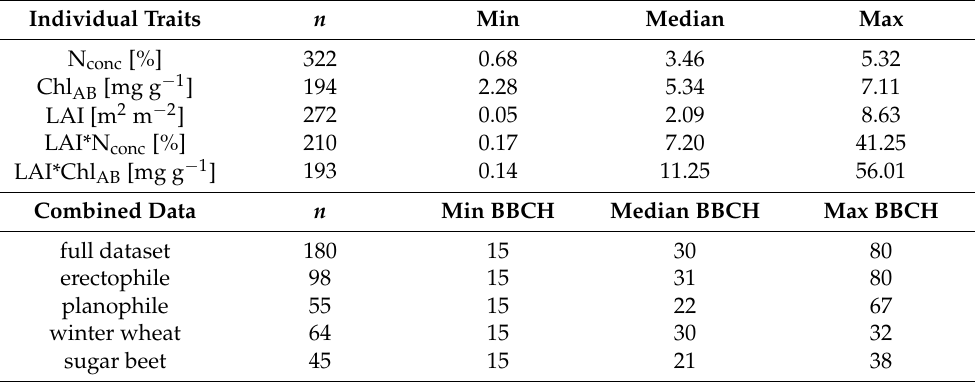
Table 1. Datasets and traits used in this